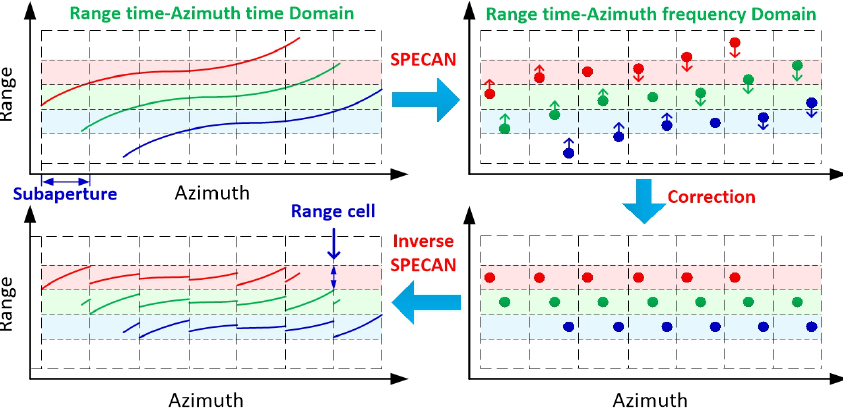
Figure 4. Schematic diagram of the fine RCMC processing based on SA